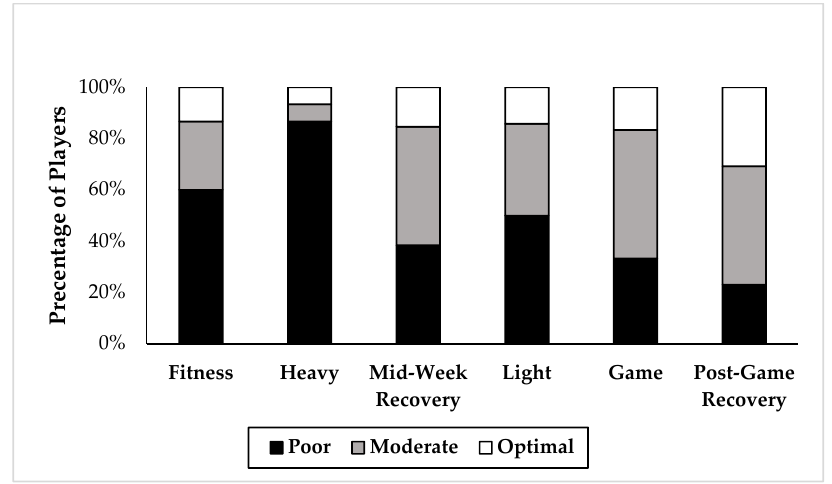
Figure 3. The relative percentage of players in optimal (white bars), moderate (grey bars), and poor (black bars) EA for 6 different training load days where optimal EA is >45 kcal/kgFFM/day, moderate EA is ≥ 30–45 kcal/kg/FFM/day and poor EA is <30 kcal/kgFFM/day ( n = 15). The forwards’ EA was significantly less on heavy days compared to all other days, (fitness p = 0.017; mid-week recovery p < 0.01; light p = 0.010; game p = 0.011; post-game recovery p < 0.01) (Figure 2). Significantly higher EA was found on the post-game recovery day, compared to the fitness day ( p = 0.05) and the heavy day ( p < 0.01) for the backs (Figure